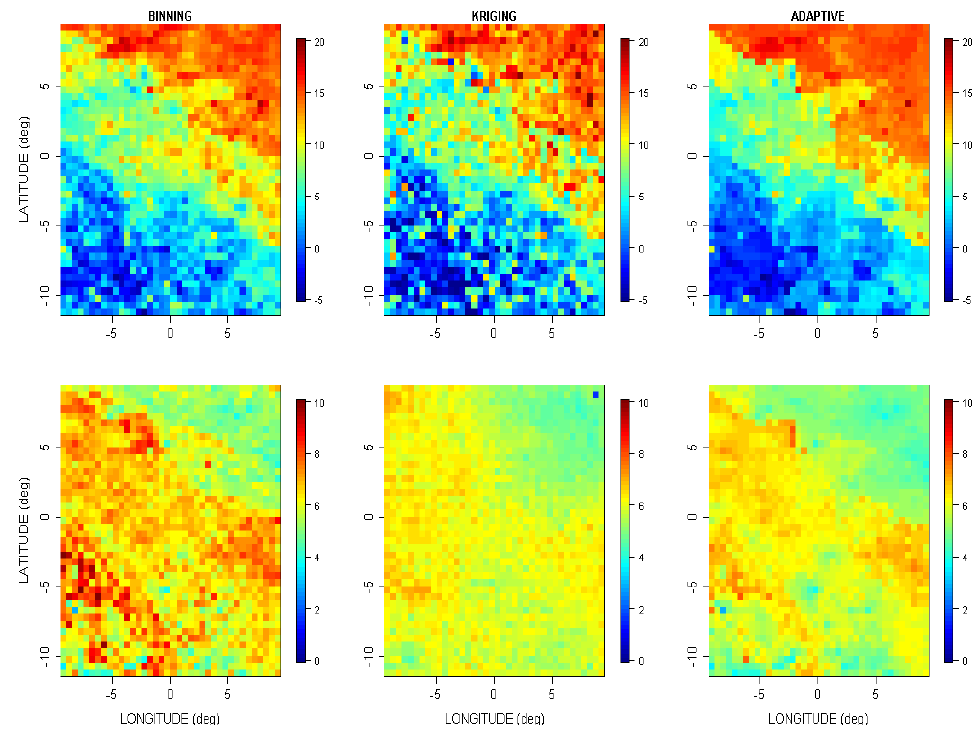
Figure 6. Same as Figure 5 but for area in central N. America. Top row: Mean σ ◦ . Bottom row: Standard deviation (SSD). Columns are, left to right, binning, kriging, and adaptive.